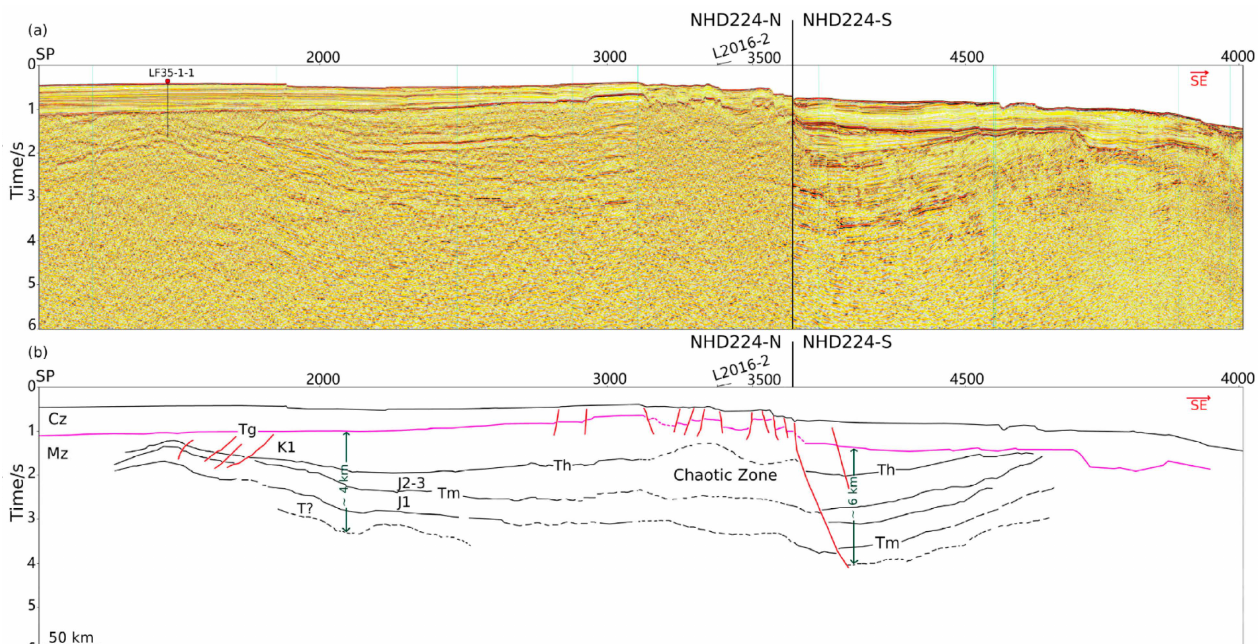
Figure 8. A MCS profile of NHD224 ( a ) that ran by a drilling well, LF35-1-1, and interpretation ( b ). Tg is the unconformity separating the Cenozoic (Cz) from the Mesozoic (Mz) Erathem; Th separates the Cretaceous (K1) from the Jurassic system (J); Tm separates the Middle and Higher (J2-J3) from the Lower Jurassic (J1) series; T? is likely Triassic; red lines denote faults. Interpretation is referred to by [9] and [11].